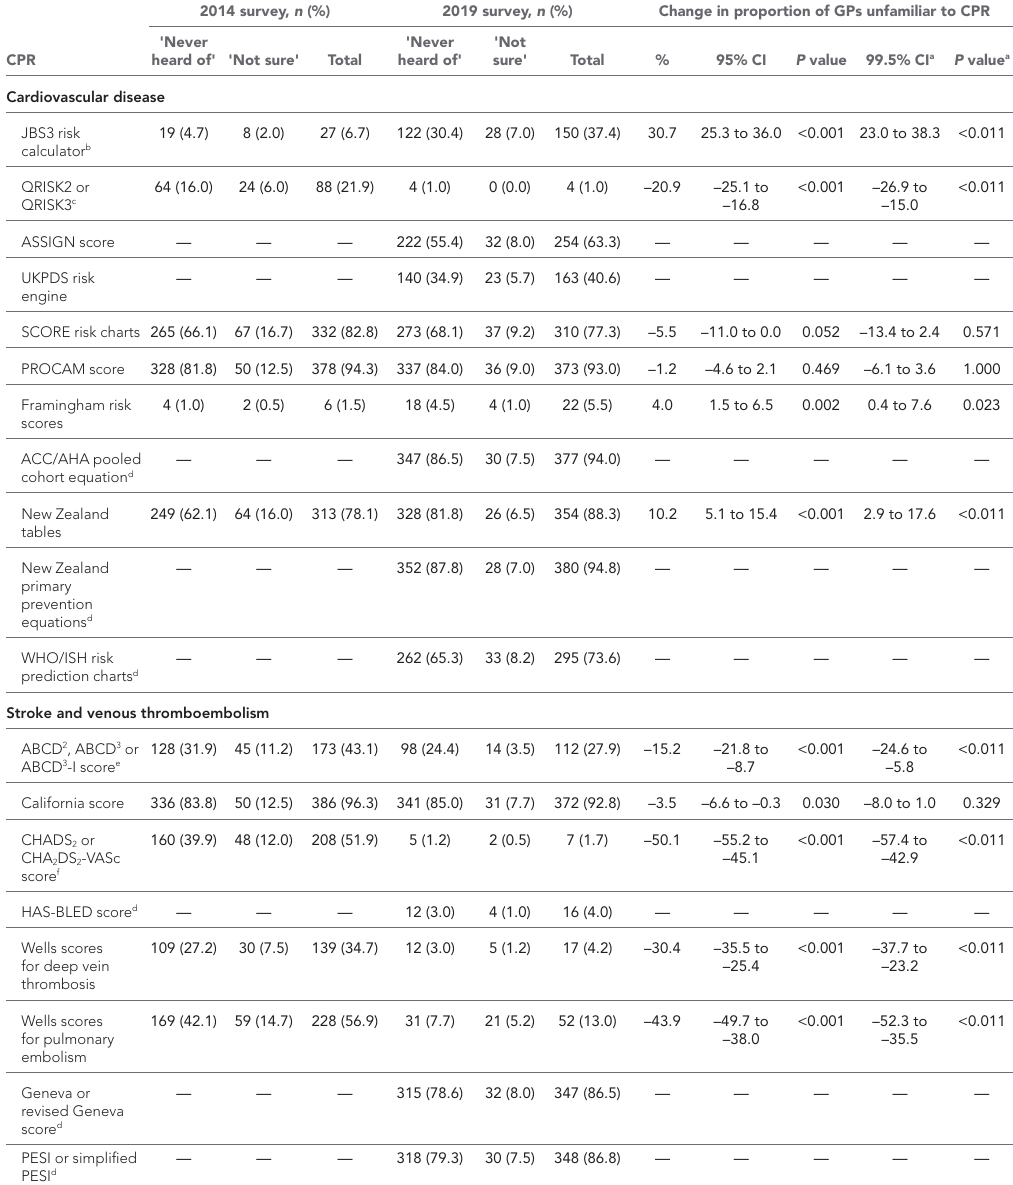
Table 3 GPs unfamiliar with clinical prediction rules (CPRs): GPs who had never heard of or who were not sure whether they heard of respective CPRs, N = 401 2014 survey, n (%) CPR